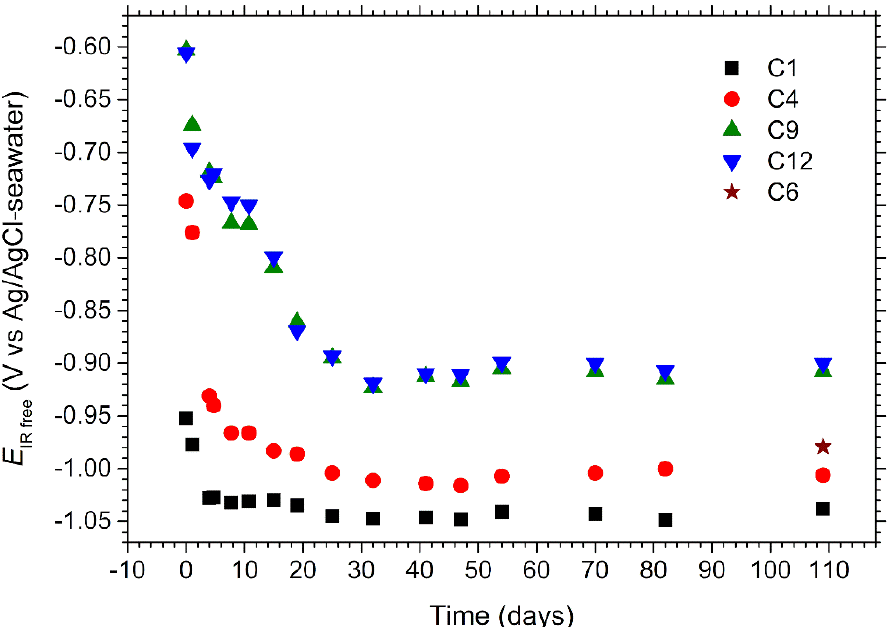
Figure 5. Evolution over time of the potential, measured with respect to the paired Ag/AgCl microelectrode, of coupons C1, C4, C9 and C12. A measurement was also performed at the end of the experiment for coupon C6 (see Section 2.2).